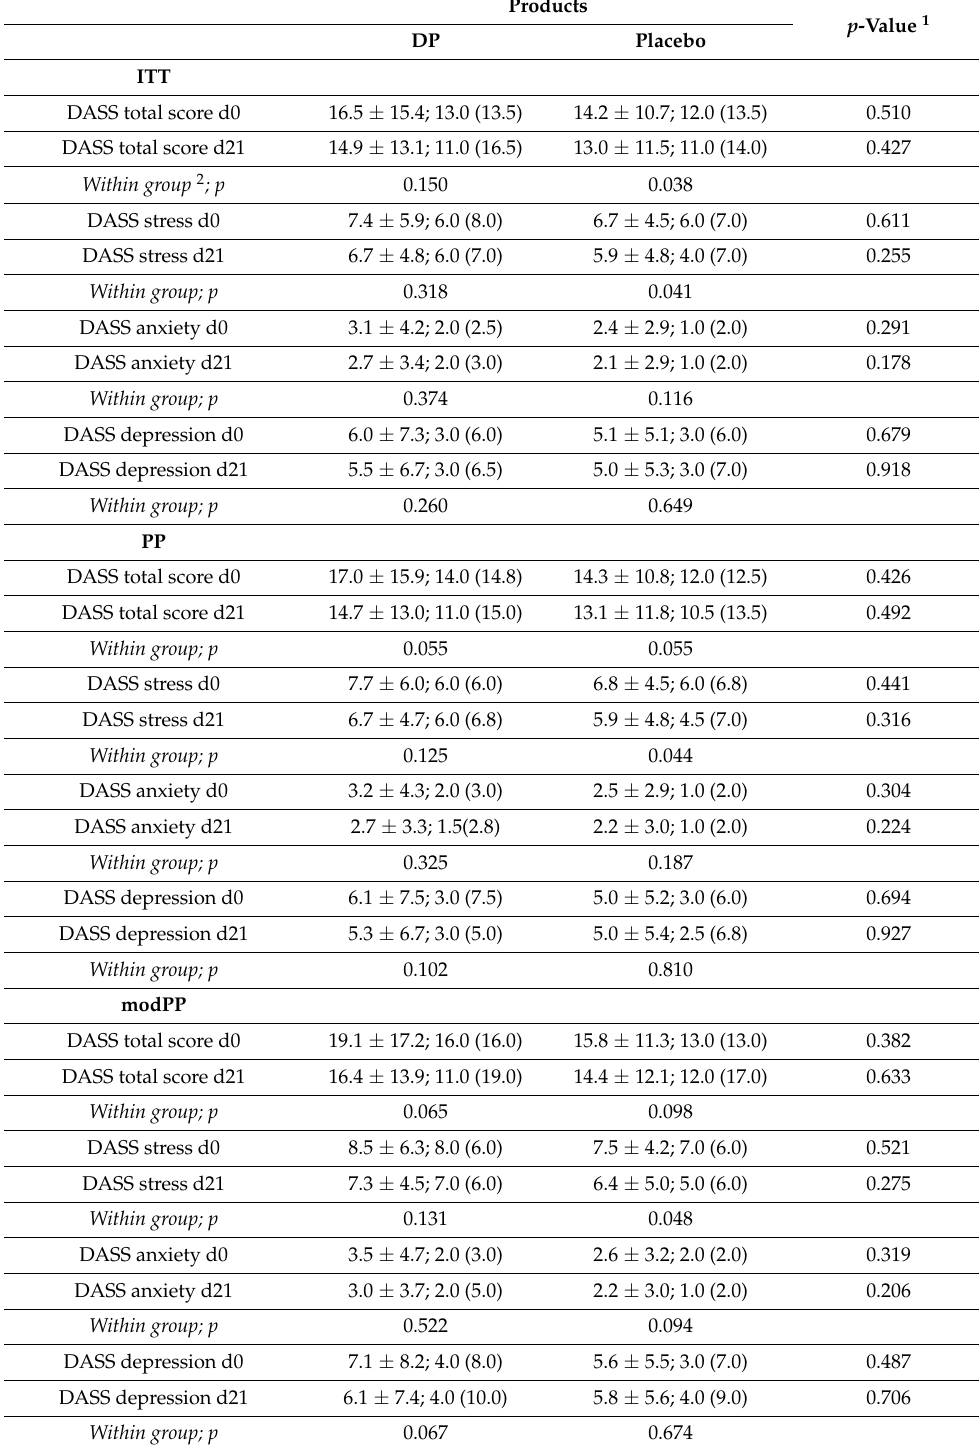
Table 4. DASS 42 outcomes (total and sub-scores) per treatment and taking intervention periods 1 and 2